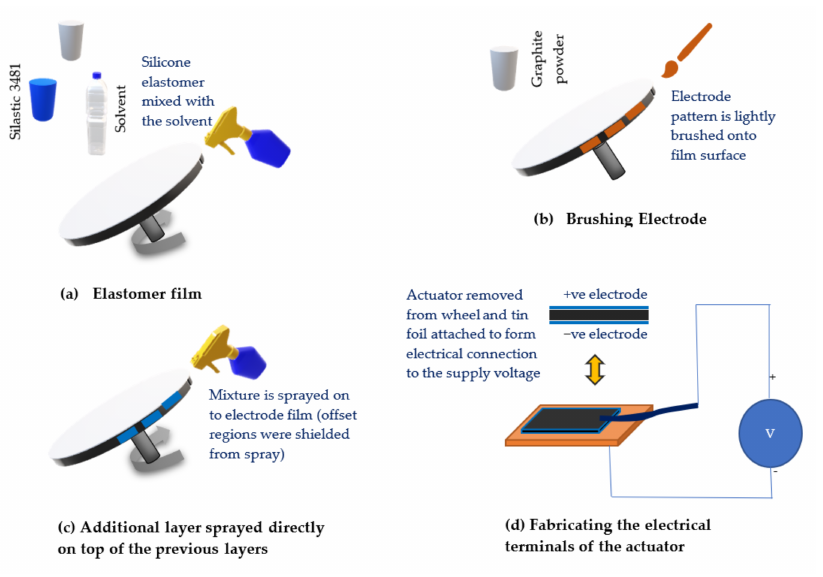
Figure 7. The fabrication process of a multilayer DEA using spray technique. Drawn based on